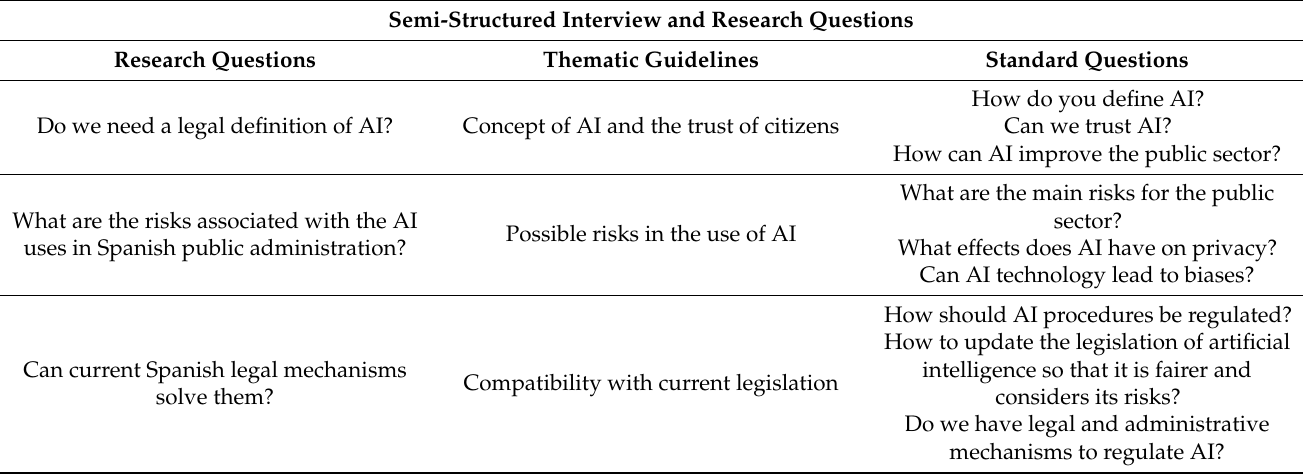
Table 1. Semi-structured interview and standard